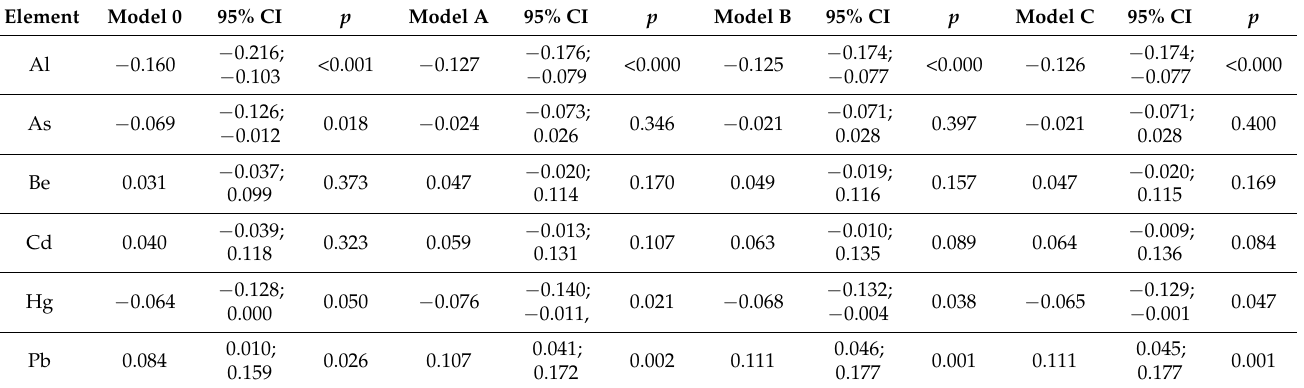
Table 3. Assessment of crude and adjusted differences in the hair content of toxic trace elements: results of multiple regression